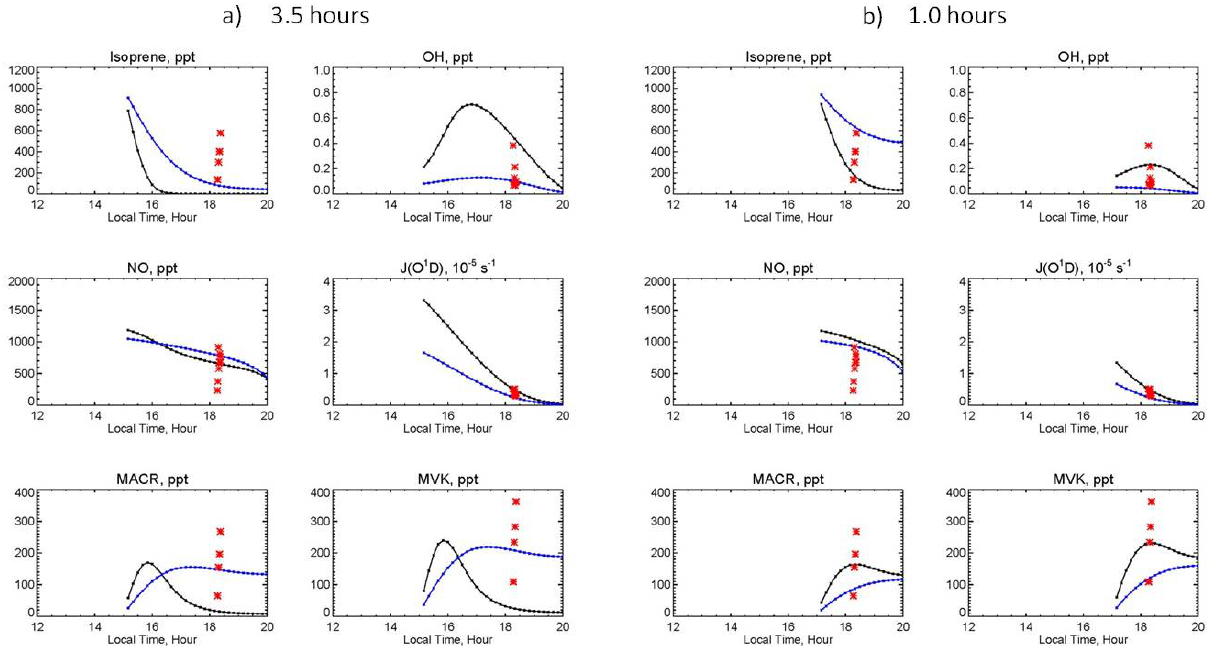
Fig. 6. LaRC DSS model results following injection of 1ppbv isoprene and 1.5ppbv NO x into the boundary layer and shows the predicted (model) and measurement (red points) results for a number of species if the injection took place at (a) 15:00 h local sun time, i.e. 3.5 h before the event was observed, and (b) 17:00 h local sun time, i.e. 1.5 h before the event was observed. For each case, the model was run forward with clear-sky J-values (black trace) and then with J-values decreased by a factor of 2 (blue trace). See text for further